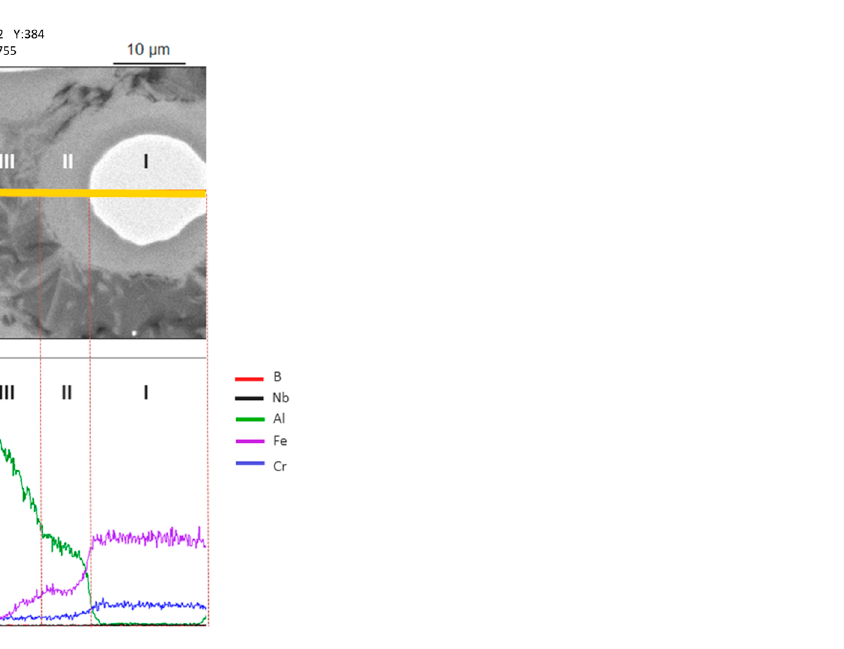
Figure 3. An area of the cross-section of the composite obtained by SPS of Al–50 vol.% Fe 66 Cr 10 Nb 5 B 19 ( a ). SPS conditions: temperature—570 °C, holding time—3 min, applied pres- sure—40 MPa. The points (1, 2, 3 and 4) in which the energy dispersive spectroscopy (EDS) analysis was conducted are marked in ( b ). BSE images.